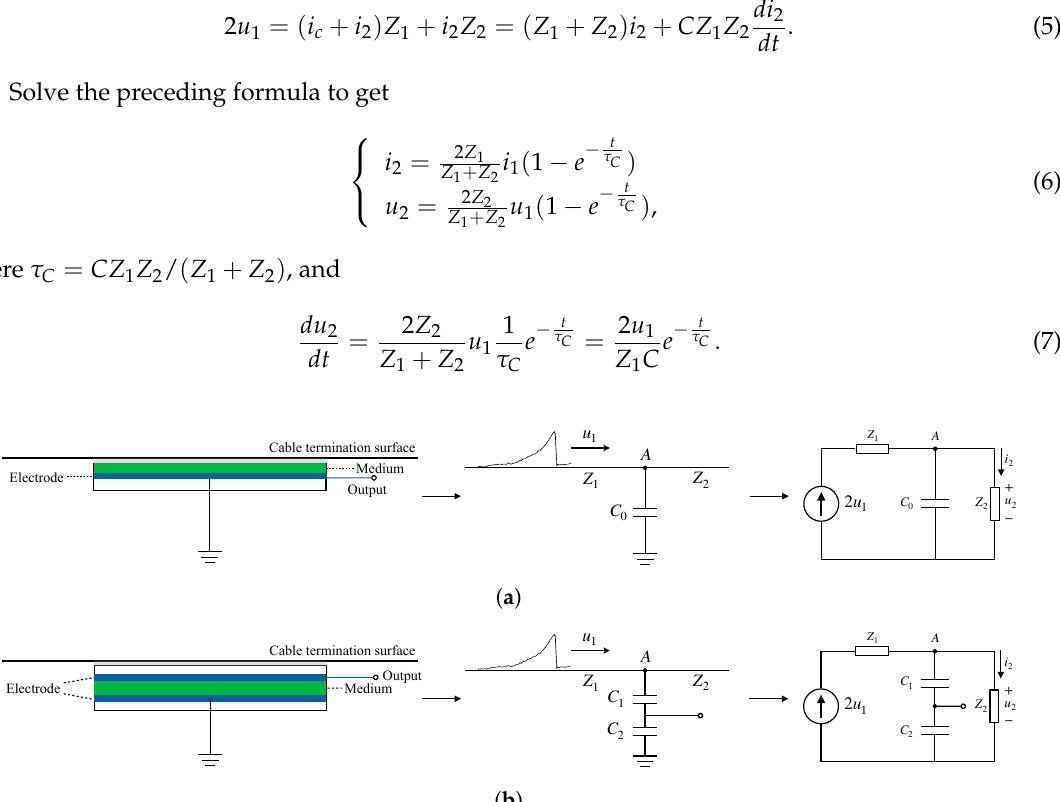
Figure 4. Schematic diagram of traditional and innovative TEV sensors and their simplified traveling wave models. ( a ) Traditional single capacitance sensor. ( b ) Innovative dual capacitance